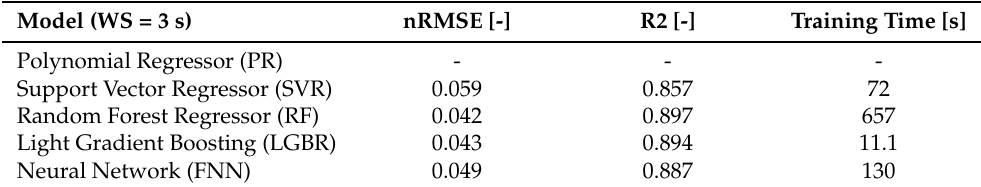
Table 6. Models’ performance using 30-sample Sliding Window (WS = 3 s).